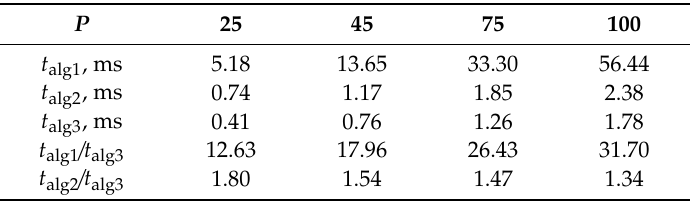
Table 2. Comparison of processing times of one image on Raspberry Pi 4 for Algorithm 1, Algorithm 2 and Algorithm